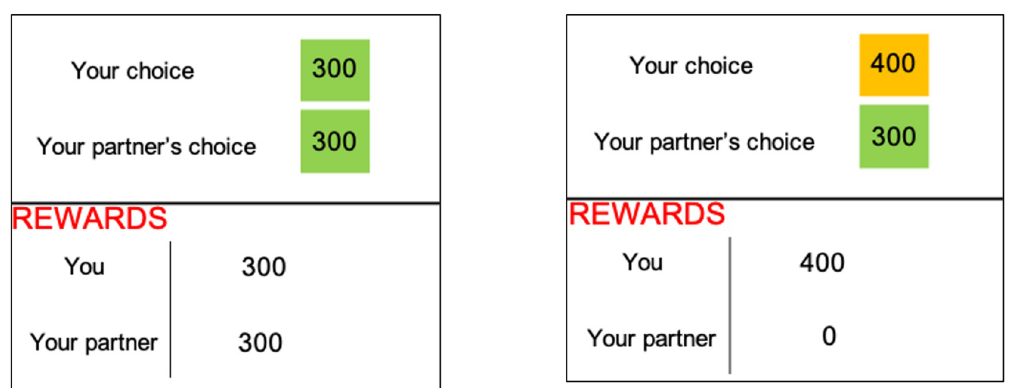
Fig 3. Experiment 1 payoff structure. Payoffs for each trial were determined as follows. If the participant chose the coordination option, then each received the corresponding amount (left box above). If the participant chose the alternative option, then the participant received the amount corresponding to the alternative option and their partner received no reward (right box above). Participants were thus aware that both their and their partner’s payoffs depended on the choice they made. Payoffs were displayed for 3000 ms before participants proceeded to the next trial. The amounts associated with the payoffs for participants’ coordination and alternative options varied, over pre-specified intervals and ranges, unpredictably across trials.